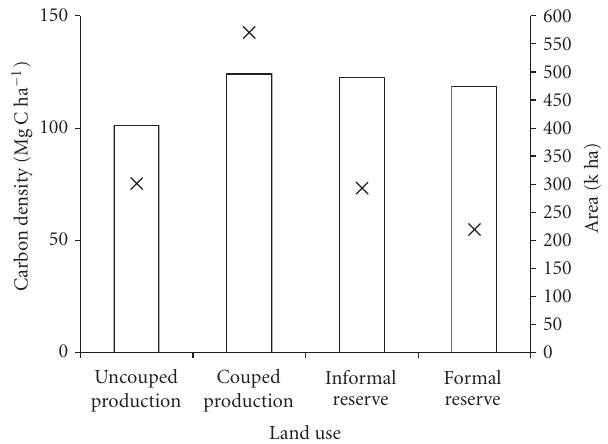
Figure 5: Standing-tree C density and area by land-use class in Tasmanian State forest. Bars denote C density, and crosses denote